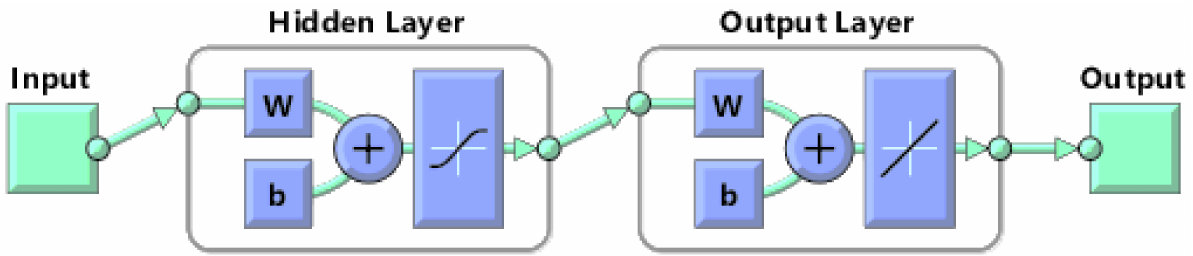
Figure 1. The two-layer feed-forward network, Source: MATLAB R2018a software. The training of ANN model architecture was performed separately on instantaneous and gradual gas injection cases. Table 3 shows the input variables and output variables used to run the training network. The input and output data from all the experiments were concatenated to one large data set. As a result, the gradual gas injection experiment resulted in a total of 1988 rows of input and output data. Similarly, the instantaneous gas injection experiment resulted in a dataset with 836 rows, 3 input columns, and 1 output